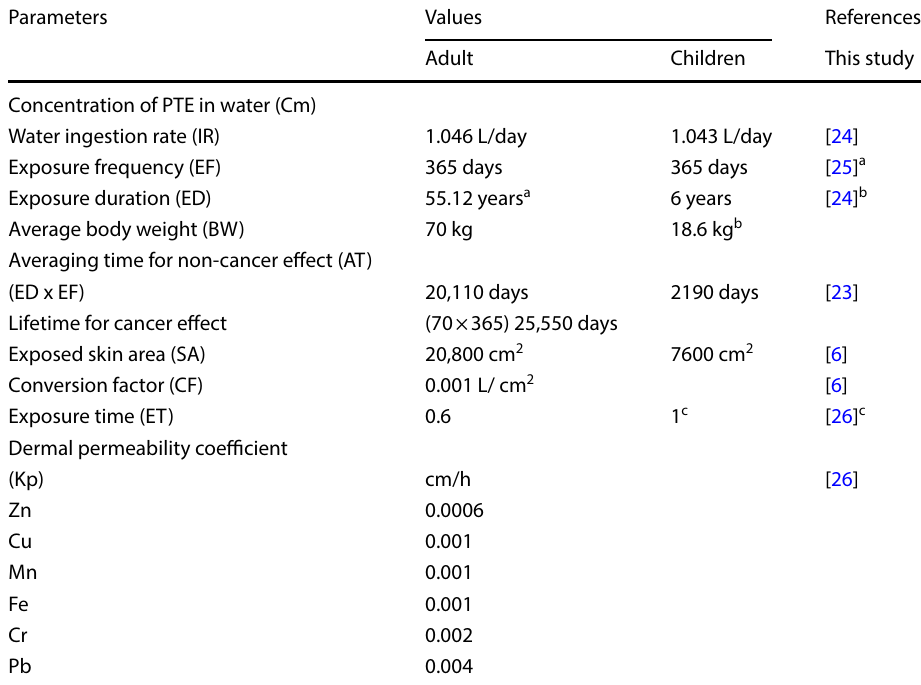
Table 2 Value of parameters used to calculate the average daily dose of heavy metals in water samples in this study